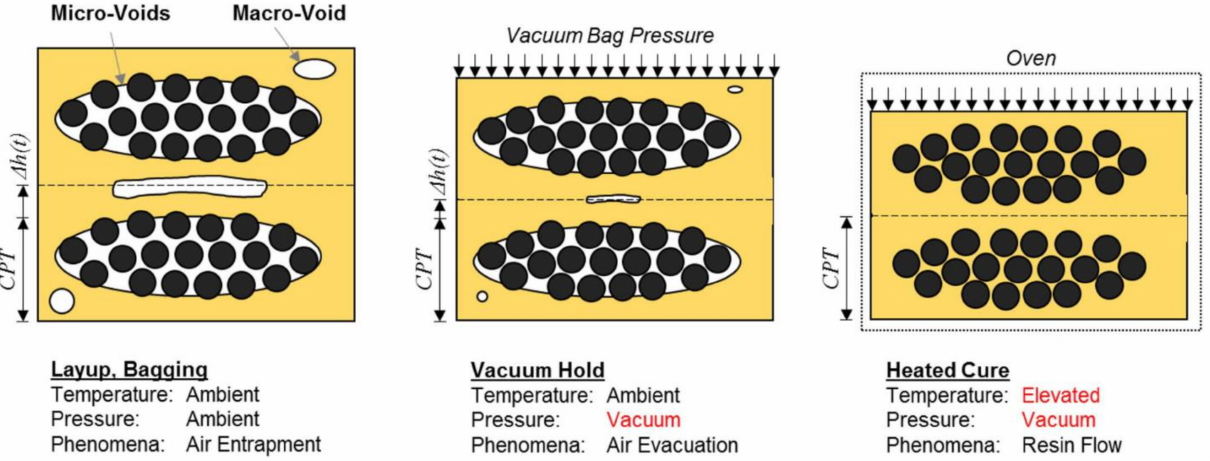
Figure 6. Consolidation Process of OoA Prepreg [21]. Reprinted with permission from